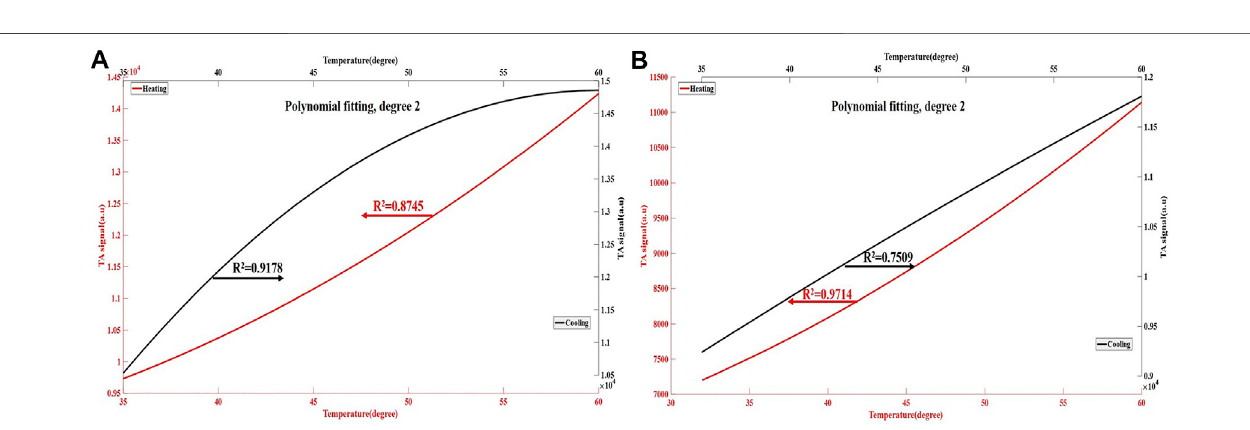
FIGURE 6 | The thermoacoustic signals changes of ex vivo liver tissue during the heating and cooling process. The red line in the fi gure (A,B) represents the polynomial curve fi tting ofthermoacoustic signal of liver tissueduring the heating process, with an R 2 values of 0.8745 – 0.9714. The black line represents the polynomial curve fi tting of thermoacoustic signal of liver tissue during the cooling process, with an R 2 of 0.7509 – 0.9178. The results show that almost a nonlinear relationship between thermoacoustic signal of liver tissue and temperature.